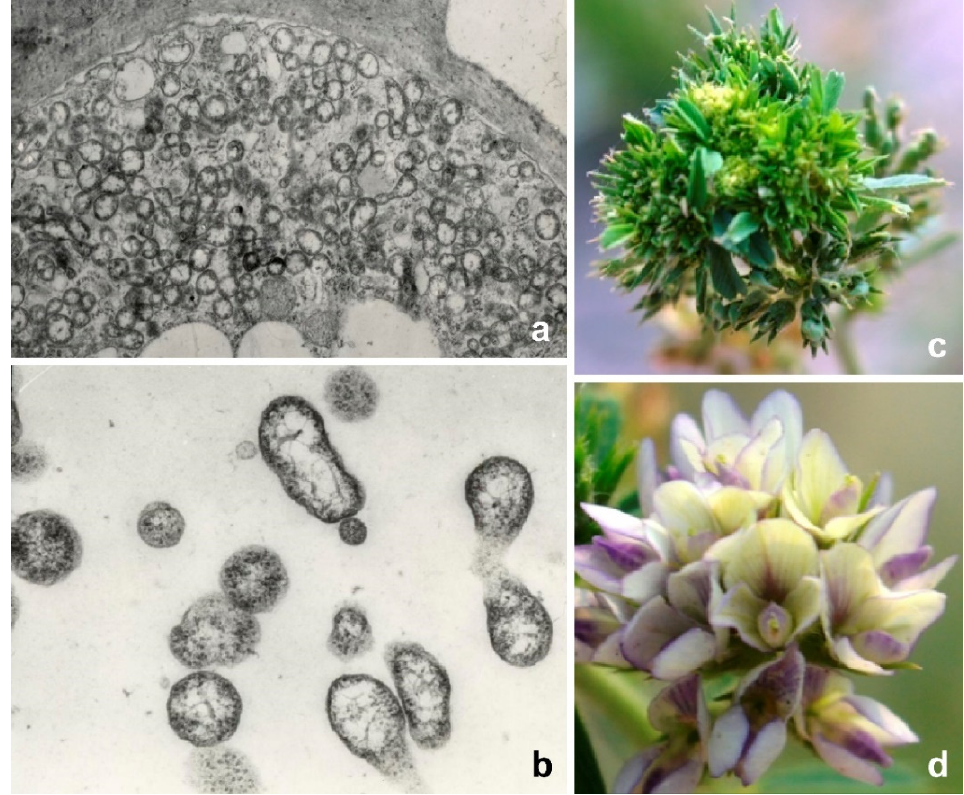
Figure 1. ( a ) transmission electron microscopy of phytoplasmas in sieve tissues (6000 × magnification) ( b ); close up (10,000 × magnification); ( c ) fenugreek ( Trigonella foenum-graecum ) inflorescence showing virescence and phyllody; ( d ) healthy inflorescence (courtesy J.N. Ahmad).